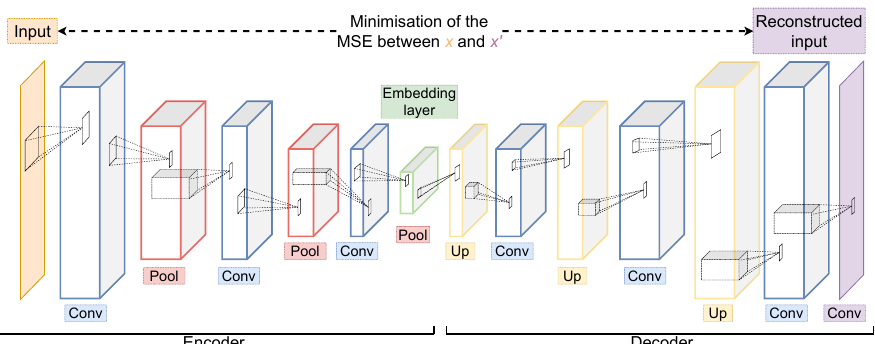
Figure 9. An example of a Convolutional Autoencoder (CAE) architecture with its Encoder and Decoder part consisting of Convolutional (blue), Pooling (red) and Upsampling (yellow) layers. During training, the network is optimised to minimise the difference between input x and output x (cid:48) . The embedding layer (green) yields a low dimensional representation of the input x